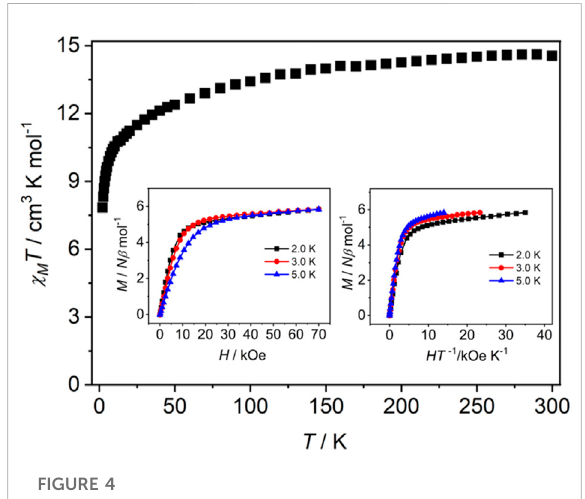
FIGURE 4 Temperature-dependent χ M T for Dy-CP .Theinsetsrepresent M - H and M - H T − 1